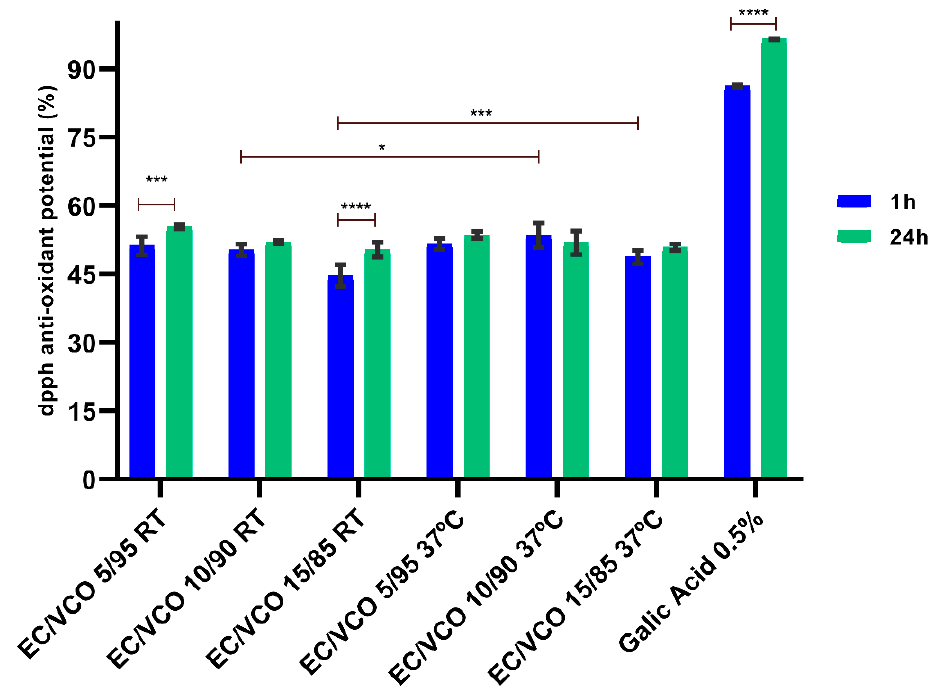
Figure 5. Antioxidant activity of the EC/VCO-based oleogels compared with gallic acid (**** p < 0.0001, *** p < 0.001 and * p < 0.05).